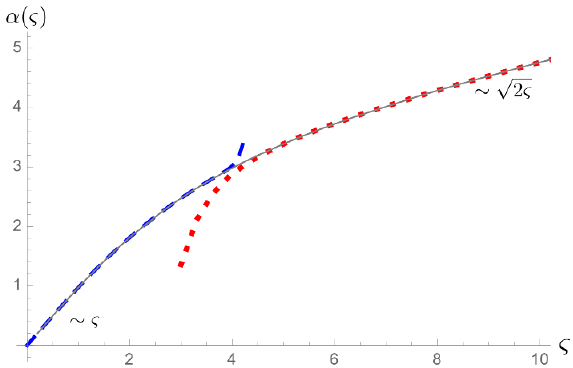
Figure 6 . Growth of S 2 -radius in the near-neck region. The solid curve is the numerical result, the blue dashed curve, the series expansion from the center (5.11), which is also used for the initial condition for the numerics, the red dotted curve, the asymptotic expansion (5.12) with the translation & ! & + (cid:1) & , where (cid:1) & ’ 0 : 216.